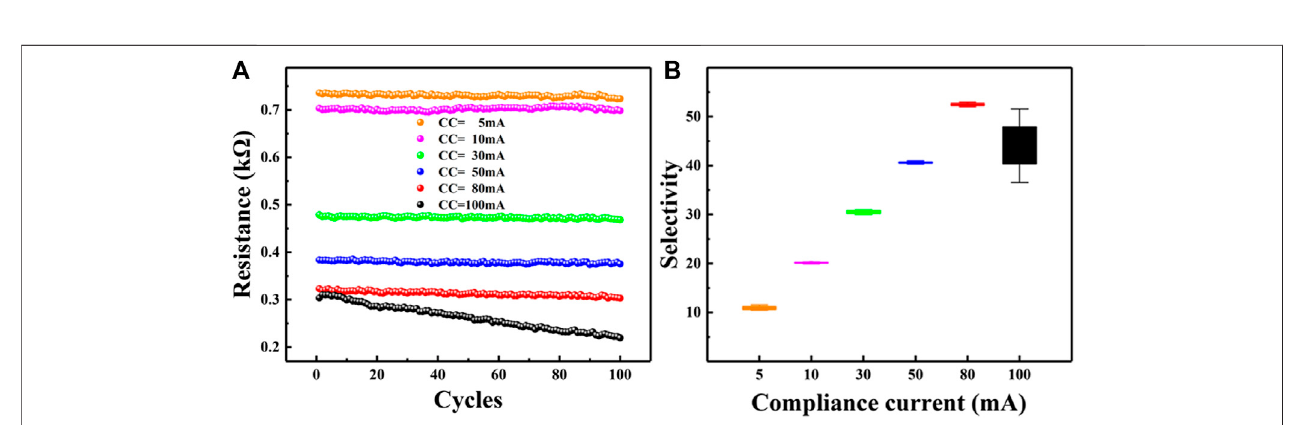
FIGURE 3 | (A) Resistance distribution at 1/2 V read of the Ti/NbO x /Ti/Pt device in 100 cycles. (B) Selectivity distribution of the device under different CC.